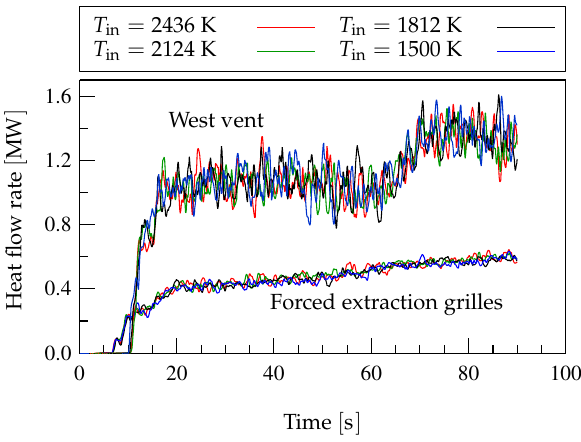
Figure 3. Heat flow rate through the forced extraction grilles and west vent, predicted by FDS and the simplified fire model with T in = 2436, 2124, 1812 and 1500 K (cases G-1 to G-4 in Table 1).